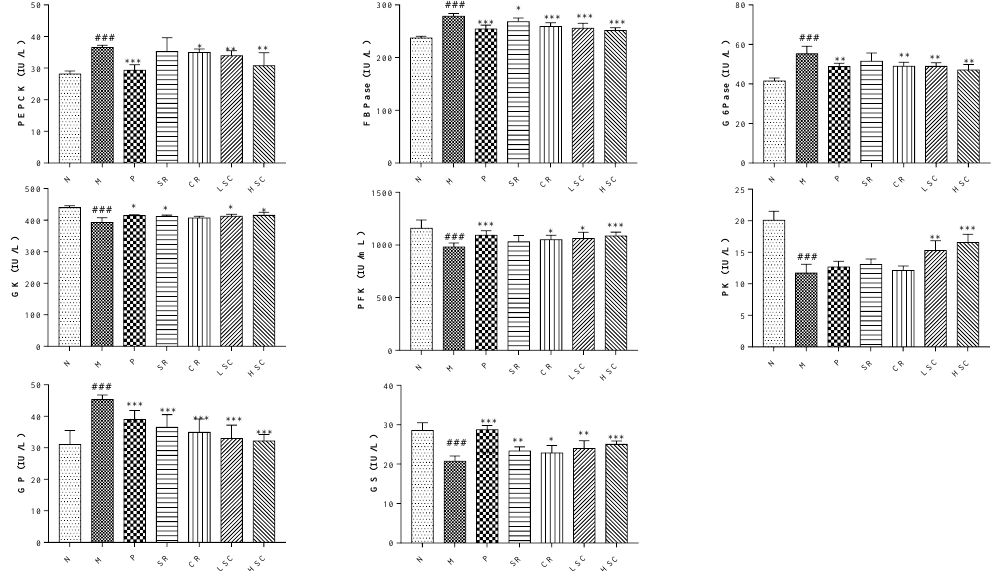
Figure 6. Activities of glucokinase (GK), phosphofructokinase (PFK), pyruvate kinase (PK), phosphoenolpyruvate carboxykinase (PEPCK), fructose-1,6-bisphosphatase (FBPase), glucose 6-phosphatase (G6Pase), glycogen synthase (GS) and glycogen synthase (GP) in livers of the normal group (N), model group (M), and groups gavaged with metformin (P), scutellaria Radix (SR), coptidis Rhizome (CR), low dose of combined extracts group (LSC) and high dose of combined extracts (HSC). The values were shown as mean ± SD. # p < 0.05, ## p < 0.01, ### p < 0.001 vs. normal group; * p < 0.05, ** p < 0.01, *** p < 0.001 vs. model group. Data were analyzed by One-way-ANOVA.